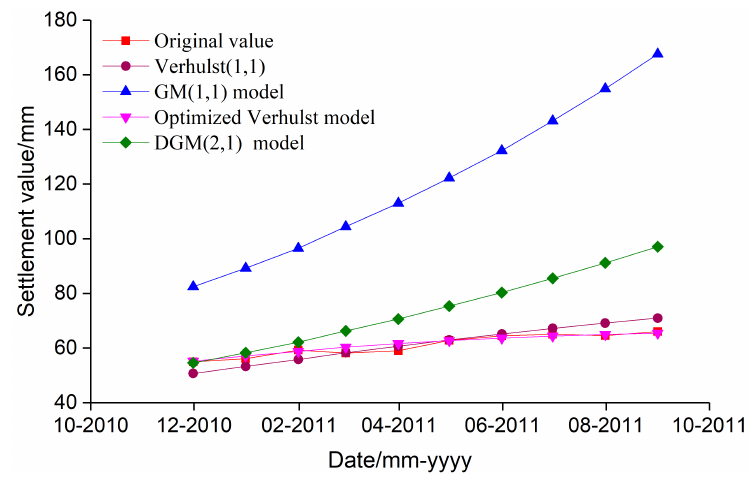
Figure 4. The curve of the original measured value and prediction values of four models.